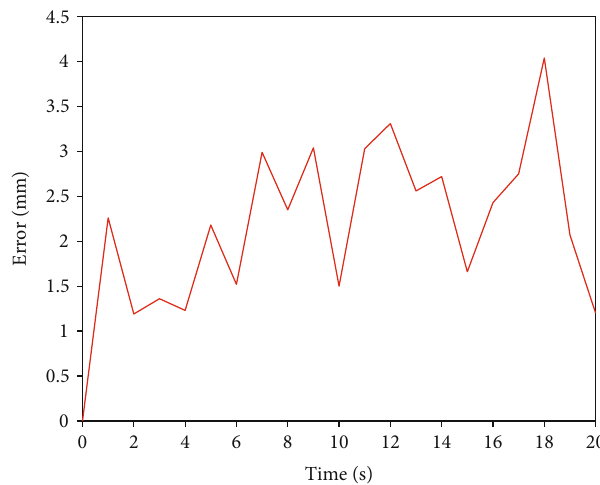
Figure 13: Axial displacement error of PID